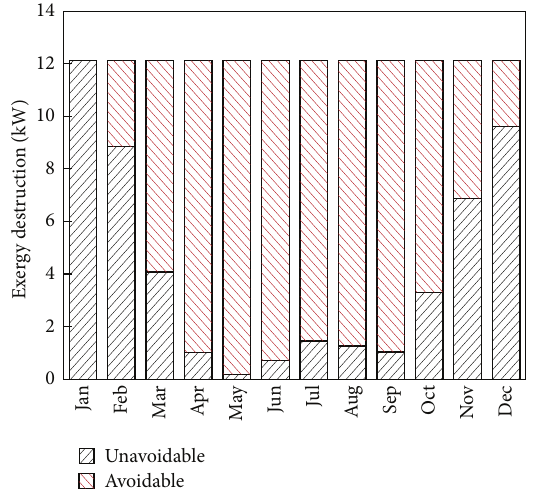
Figure 12: Exergy destruction rate of PV system during a year.